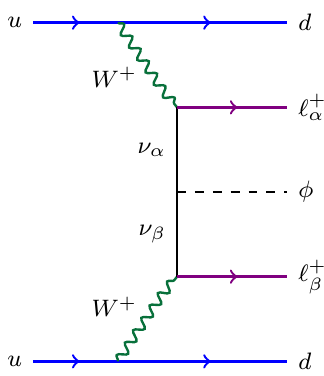
Figure 1 . Representative Feynman diagram for the production of leptonic scalar (cid:30) at the LHC. . 10 (cid:0) 4 [5] have been set by 0 (cid:23)(cid:12)(cid:12) experiments like NEMO-3 [11{ limits on the coupling (cid:21) ee 16], KamLAND-Zen [17], EXO-200 [18] and GERDA [19]. In this paper, we show